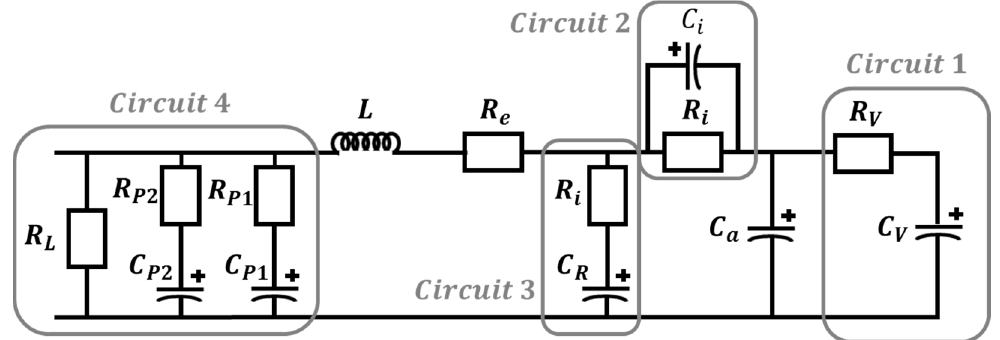
Figure 2. SC frequency domain model proposed by Rafik et al (adapted from [20]).